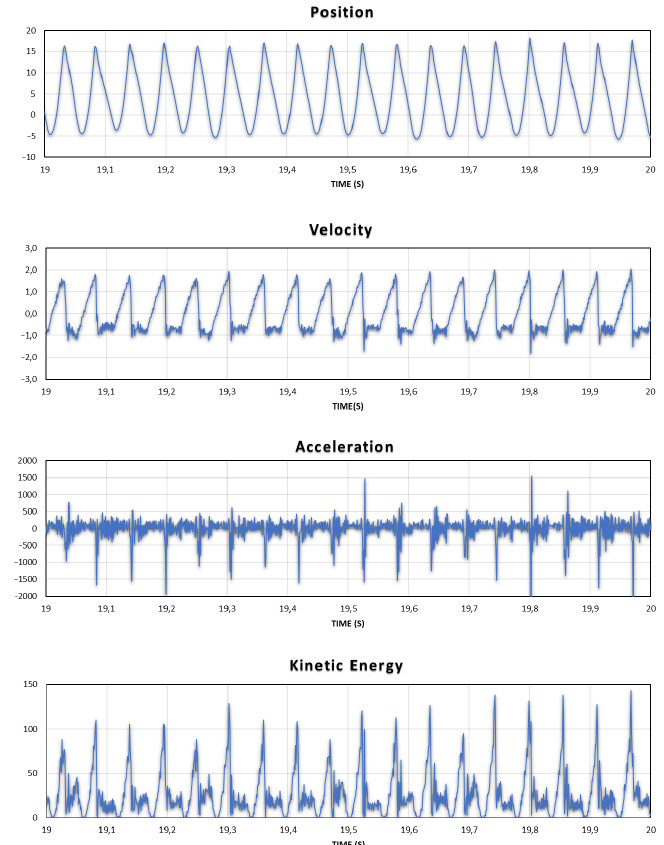
Figure 17. Dynamic parameters of the electric-hammer testing at 18 Hz: chisel position (mm), velocity (m/s), acceleration (m/s 2 ), and kinetic energy (J) [114].